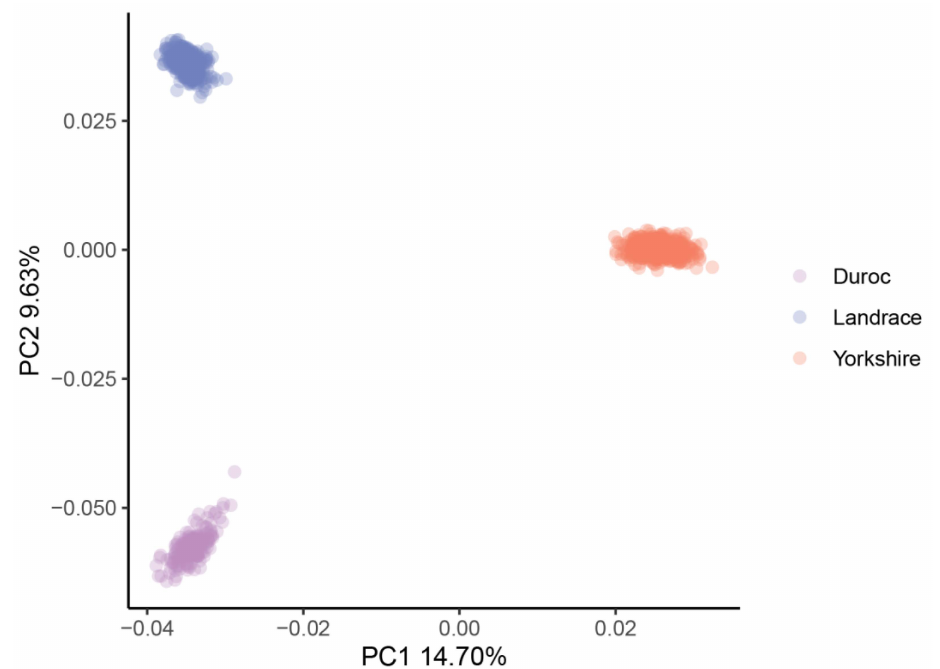
Figure 1. PCA plot for the three pig populations. PC1 as first principal component; PC2 as second principal component.